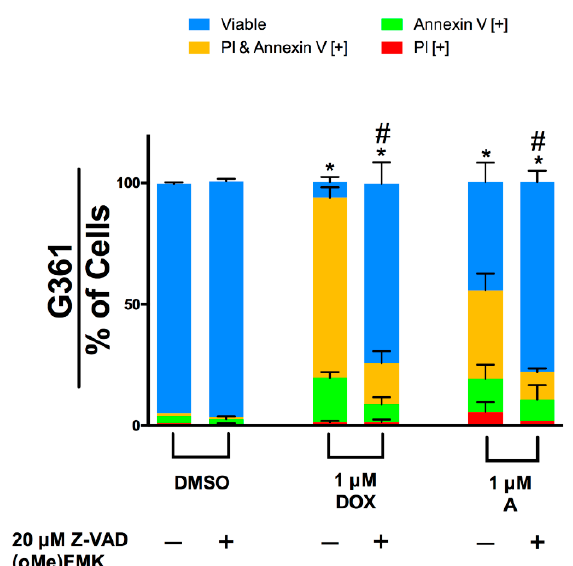
Figure 8. Induction of apoptosis by Compound A is caspase dependent. G361 melanoma cells were pre-treated with or without the caspase inhibitor Z-VAD-FMK for 30 min, followed by treatment with Compound A for 48 h. Cells were stained with Annexin V and propidium iodide to quantify apoptosis. Image based cytometry was utilized to assess apoptosis. The y -axis represents the percent of cells positive for Annexin V (green), PI (red), Annexin V and PI (orange), or cells negative for Annexin V and PI (blue). Values are expressed as mean ± SD from three independent experiments. * p < 0.05 vs. DMSO control (comparison of viable cells only); # p < 0.05 vs. individual chemotherapeutic treatment (comparison of viable cells only). Doxorubicin (DOX) was used as a positive control. A = Compound A, CUR = Curcumin.